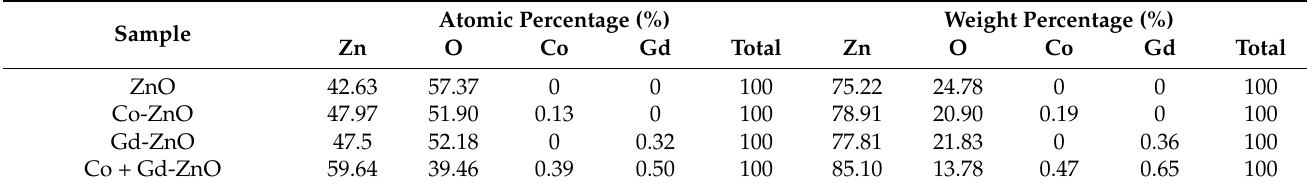
Figure 3. EDX spectrum of ( a ) pure ZnO ( b ) Co-added ZnO ( c ) Gd-added ZnO and ( d ) Co/Gd-added ZnO. Table 2. EDX analysis of pure and added nanoparticles of ZnO.